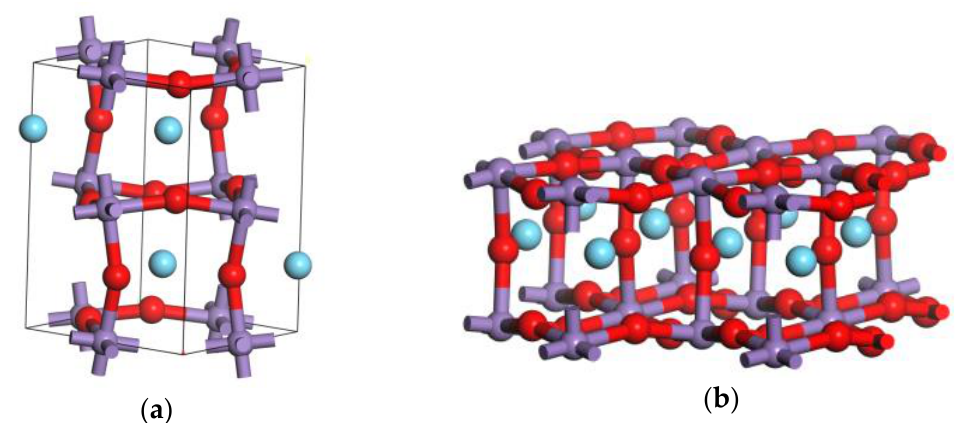
Figure 1. The conventional cell and (0 0 1) surface of LaMnO 3 . ( a ) the conventional cell of LaMnO 3 , ( b ) the (0 0 1) surfac of LaMnO 3 (red spheres, purple spheres, and pale blue spheres represent the O anions, Mn cations, and La cations, respectively).